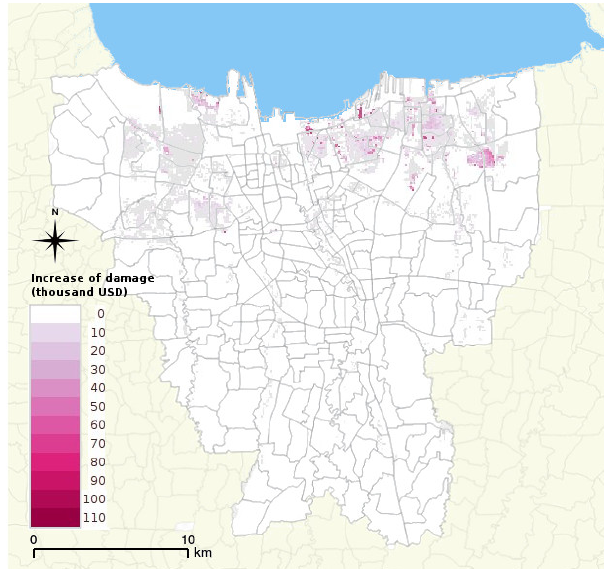
Figure 8. Increase of damage per grid cell at a return period of 100 years between the baseline condition and idealized land use map 2030 due to land subsidence